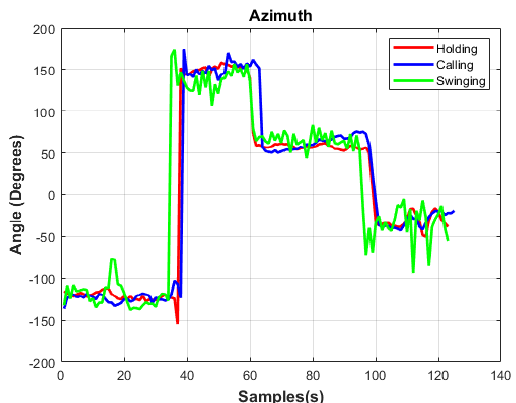
Figure 13. the experimental path direction estimation for the three modes of carrying of the smartphone.